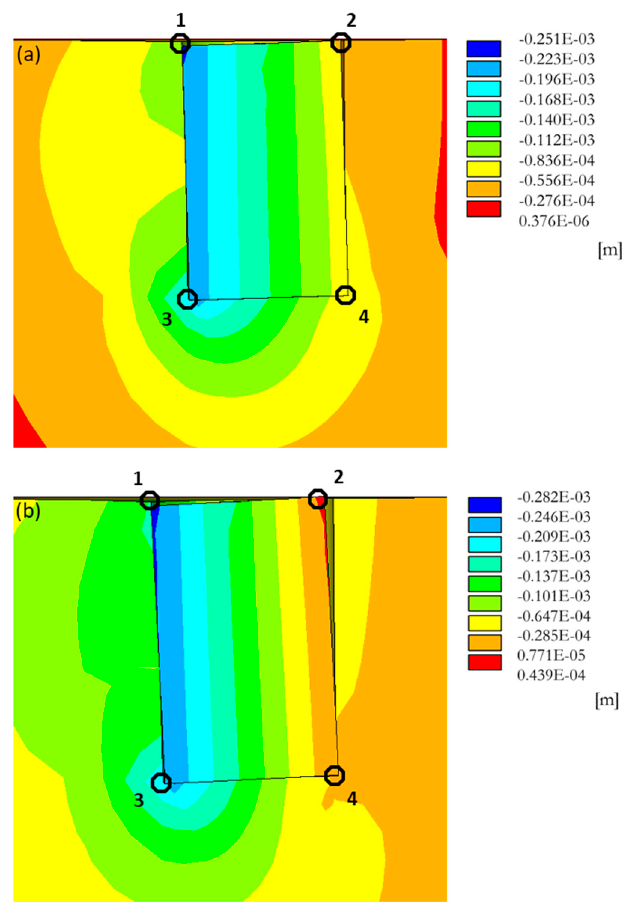
Figure 27. ( a ) Horizontal and ( b ) vertical deformations in the plane of symmetry, expressed in m, due to the simultaneous application of N, V and M stresses determined through